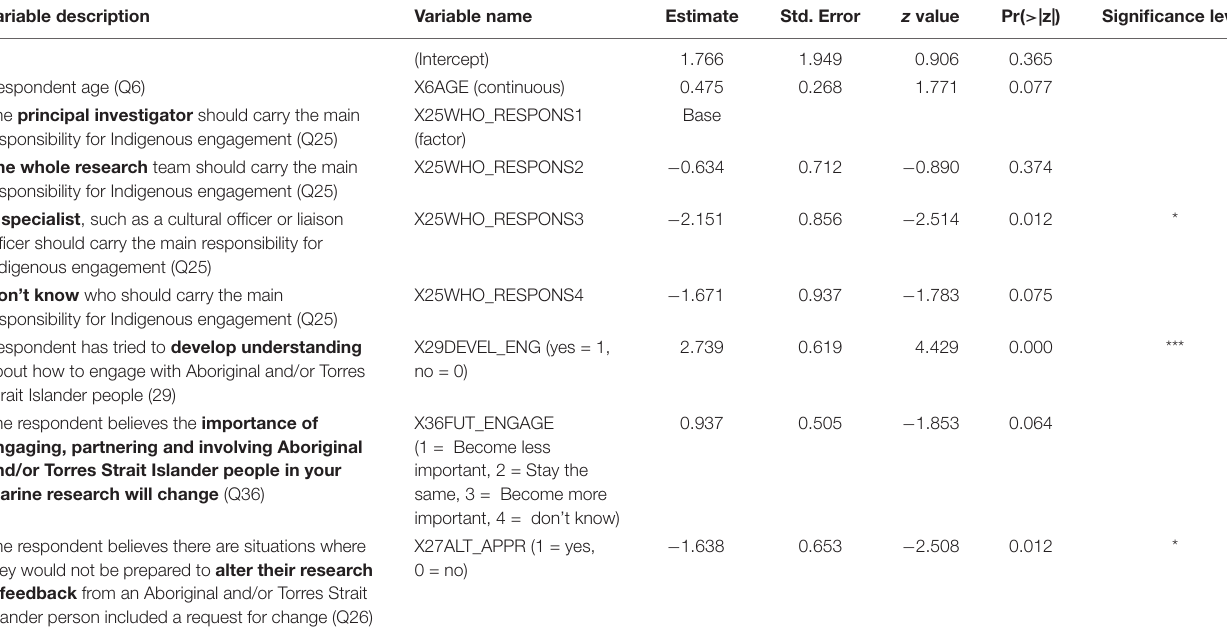
FIGURE 3 | Researchers’ focus on Indigenous engagement in stages of marine research projects measured as percentage of survey respondents ( n = 76). TABLE 1 | Fixed effects for logit model explaining marine researcher engagement with Aboriginal and/or Torres Strait Islander communities. Variable